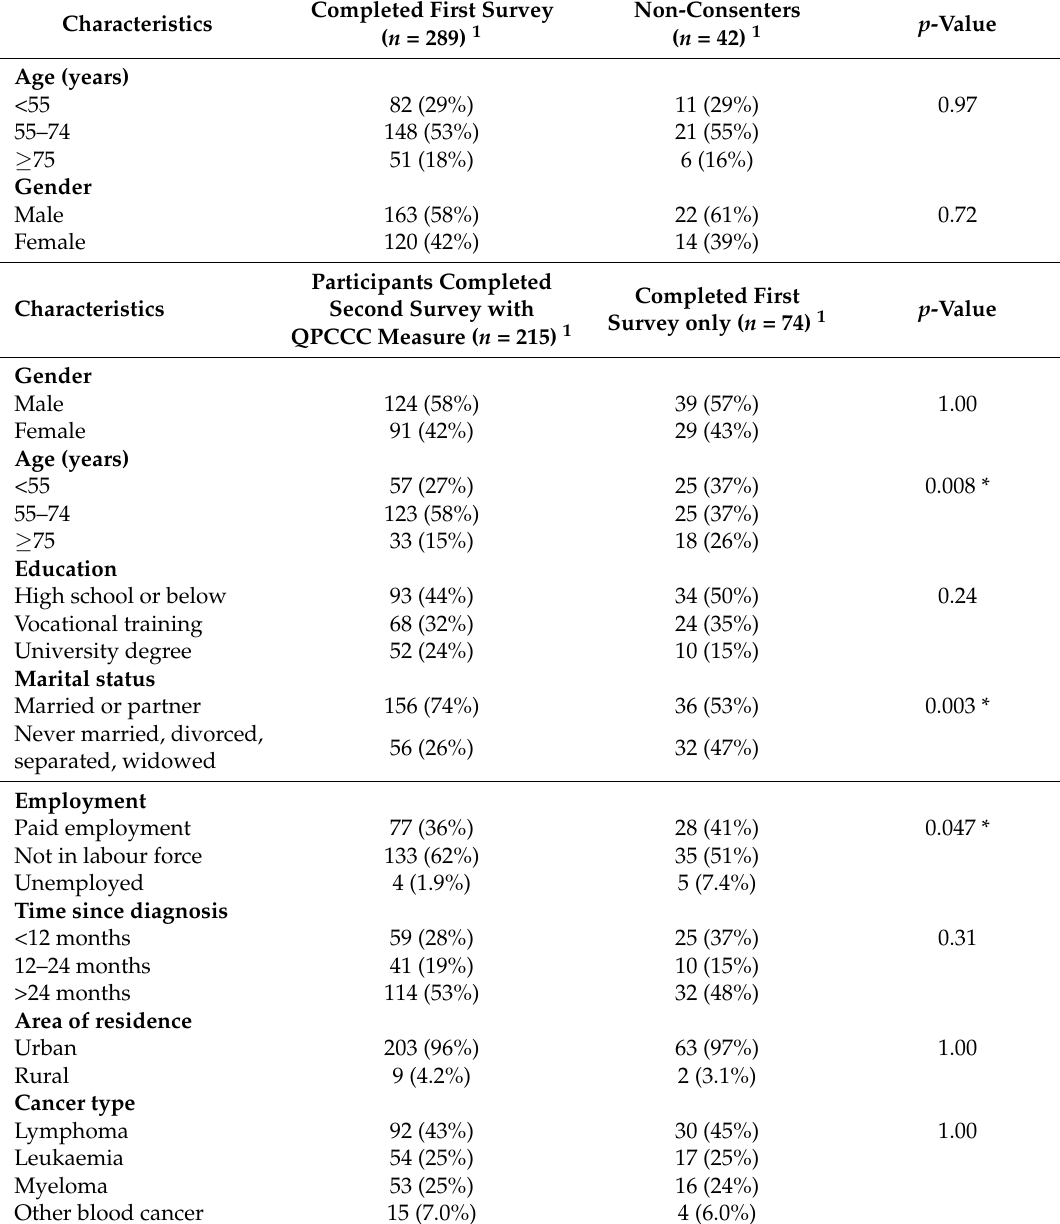
Table 2. Comparison of (a) patients who completed first survey and non-consenters and (b) participants who completed the QPCCC measure in second survey and those who completed first survey